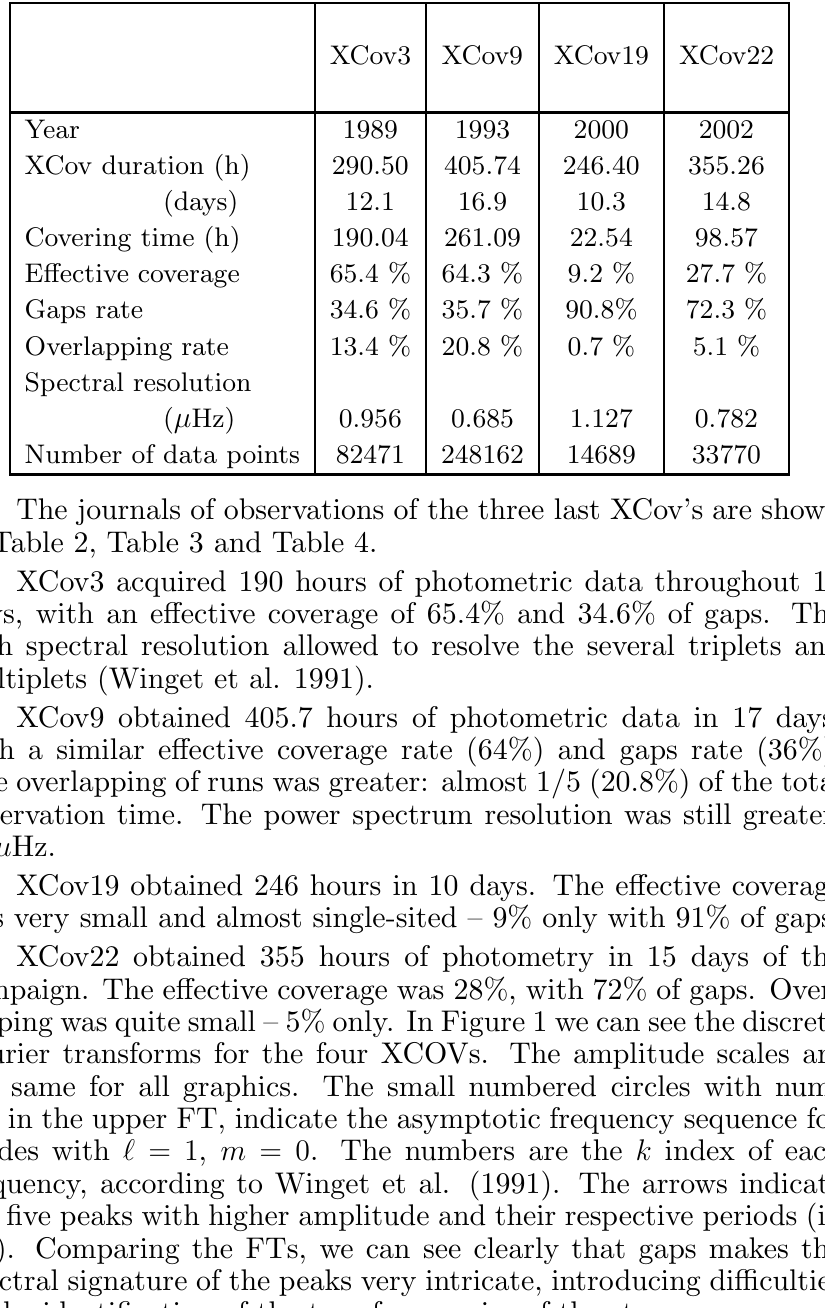
Table 1. WET Observations of PG